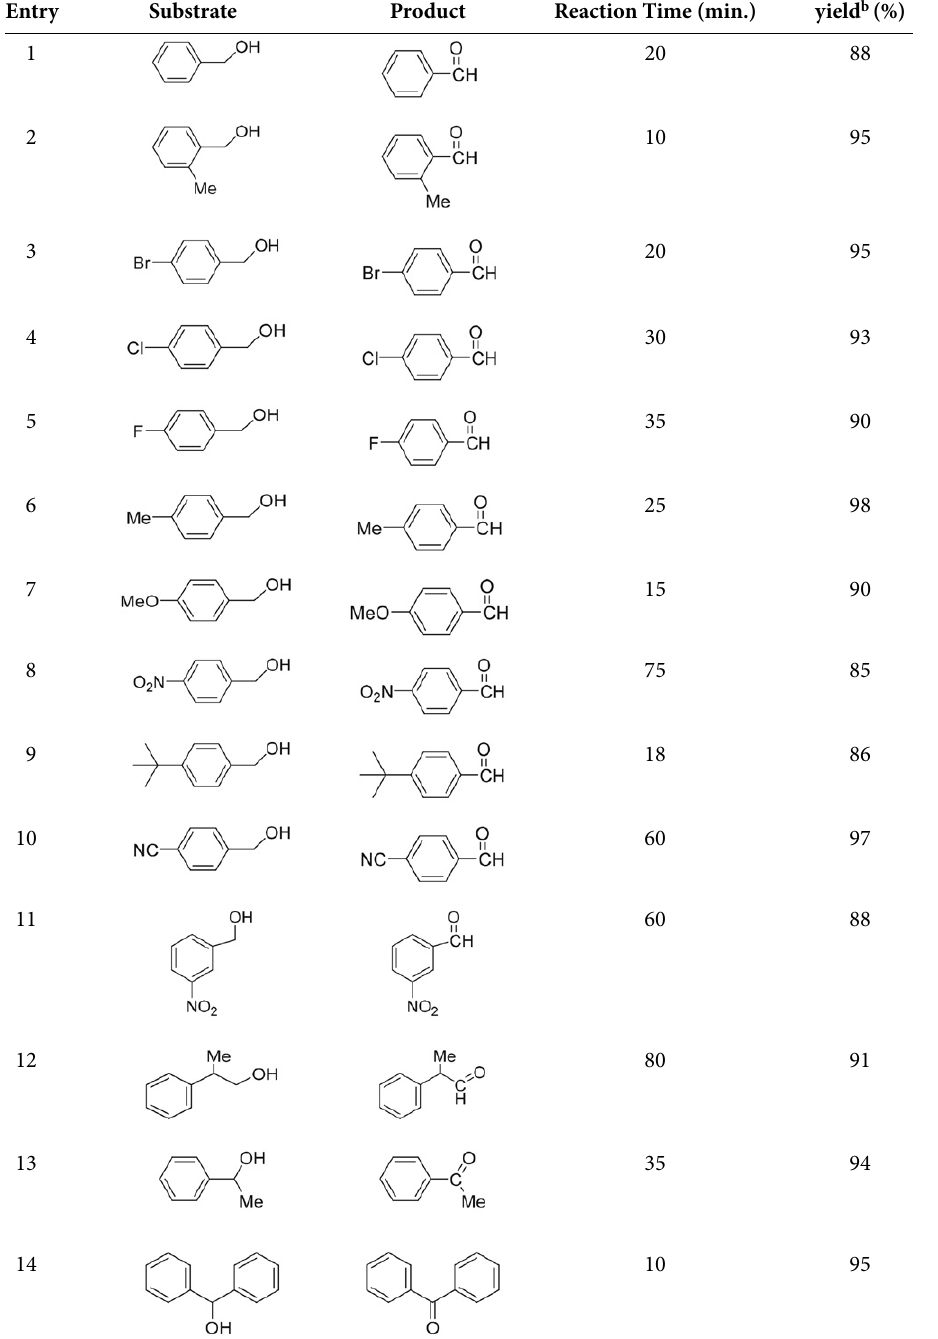
Table 2. Fe 3 O 4 @ PyHBr 3 MNP catalyze the oxidation of alcohols to carbonyl compounds. a